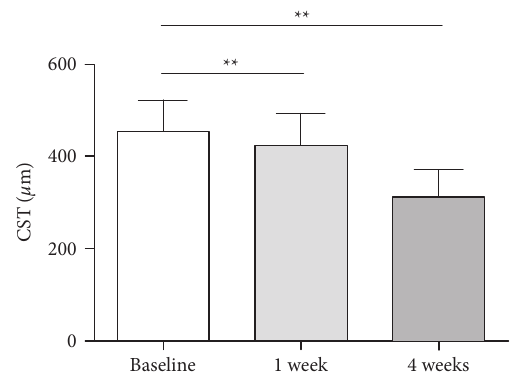
Figure 3: Changes in the CST before and after switching to PSTA treatment in eyes with refractory DME. ∗∗ P < 0 . 01 vs. the baseline